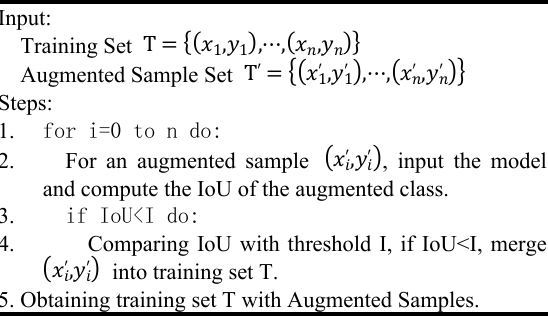
Algorithm 1: Algorithm for Screening Augmented Samples